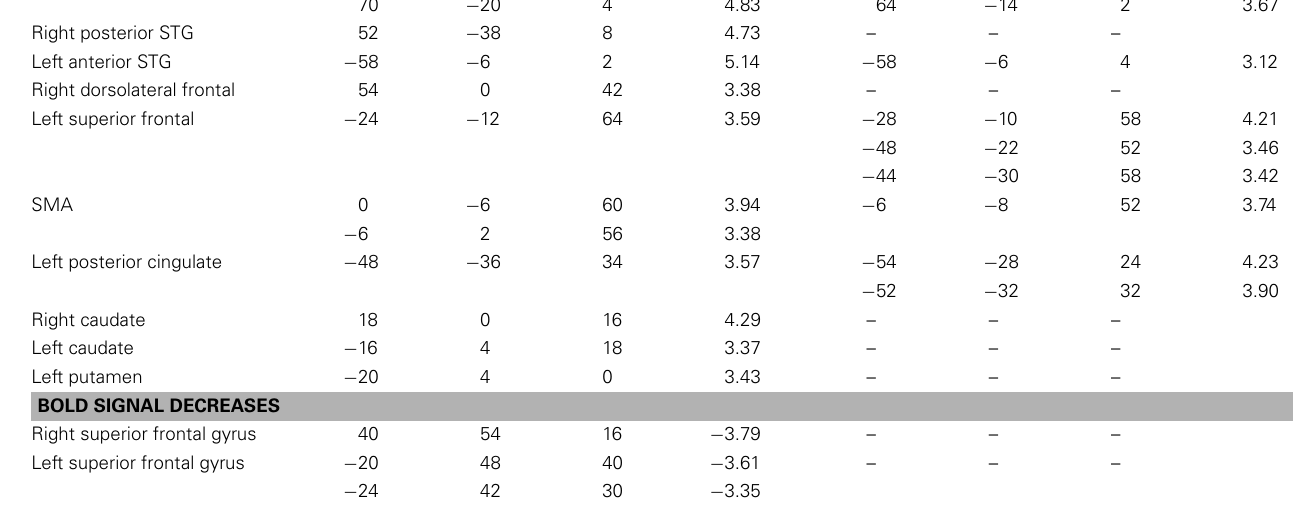
Table 2 | Pre- and post-training covariation analysis. Active condition.